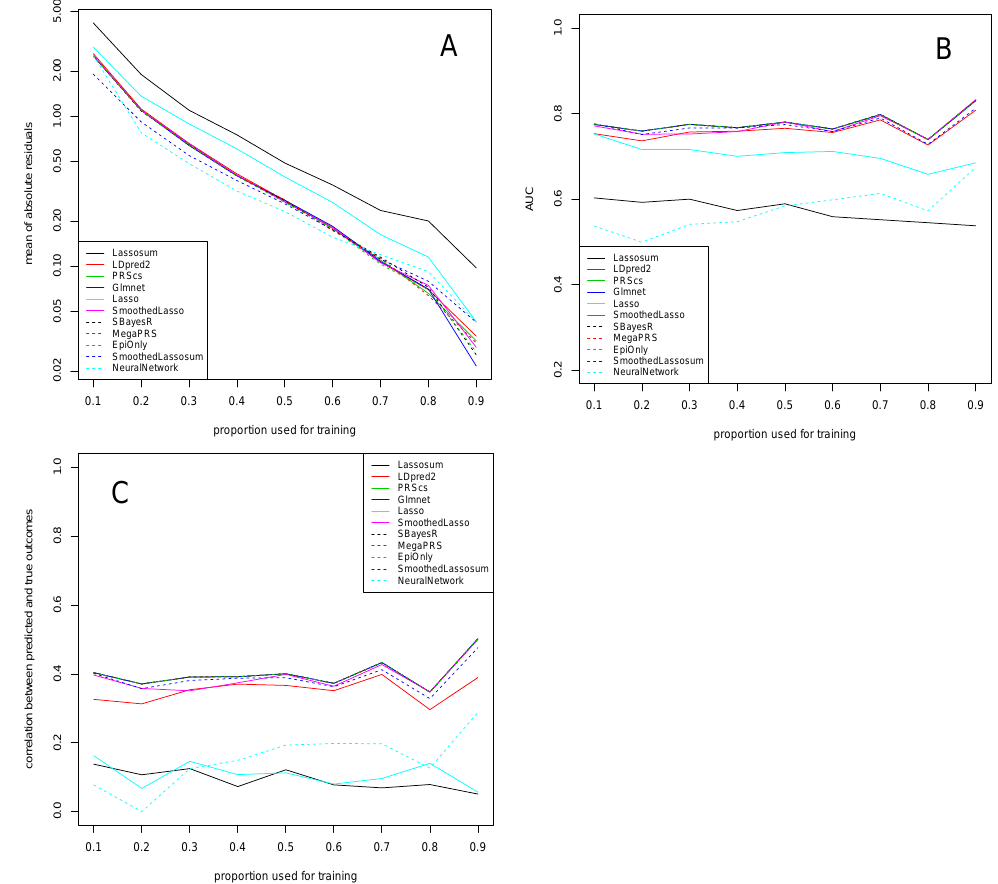
Figure 2. Dataset of AD-by-proxy phenotypes of [14]. Mean of absolute residuals ( A ), AUC ( B ), and correlation between predicted and true outcomes ( C ) as a function of the proportion of data used for training. Plotted with